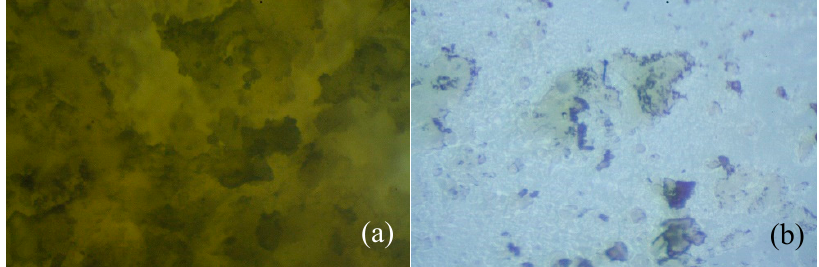
Figure 8. Optical micrographs of the HMFA_ECL oligomers ( a ) before and ( b ) after the microbial degradation.